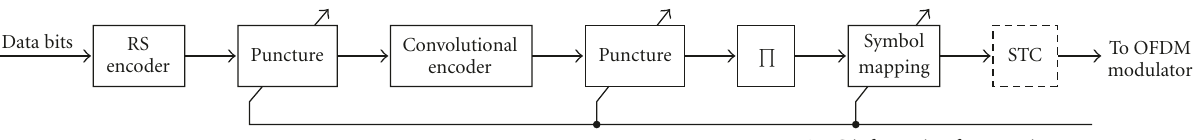
Figure 1: Encoding and modulation at the transmitter.